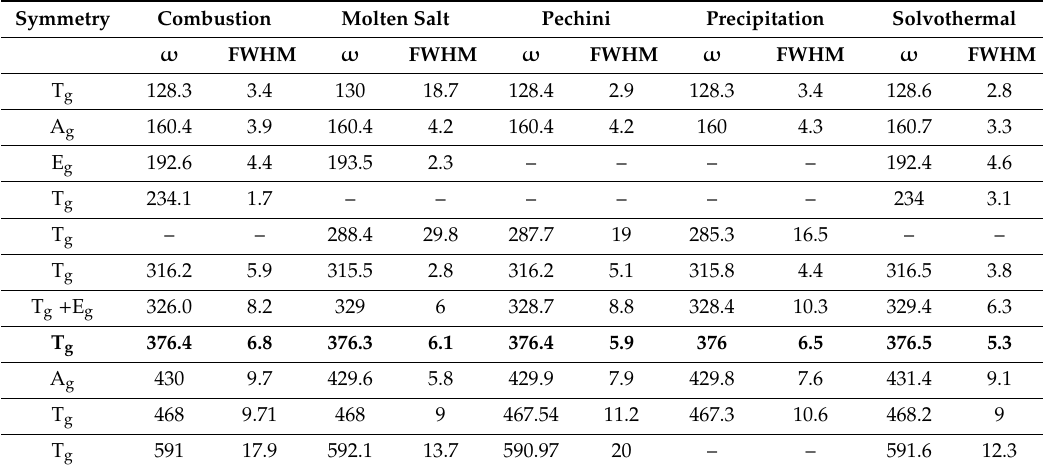
Table 1. Raman peaks position, width (FWHM) and their symmetry assignment of Y 2 O 3 : Pr 3+ NCs